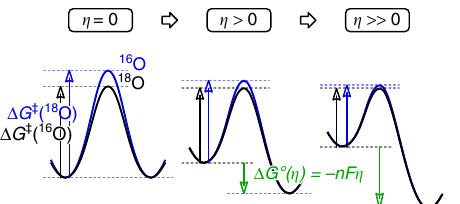
Fig. 3 Schematic explanation for the decrease of selectivity upon increase in overpotential in electrochemical reactions. A change in mechanism is not required to explain a decrease in selectivity. The scheme includes the free enthalpy of activation Δ G ‡ , and the free enthalpy of reaction Δ G °, which depends on the number of electrons n exchanged in the rate-determining step, the Faraday constant F and the overpotential ƞ